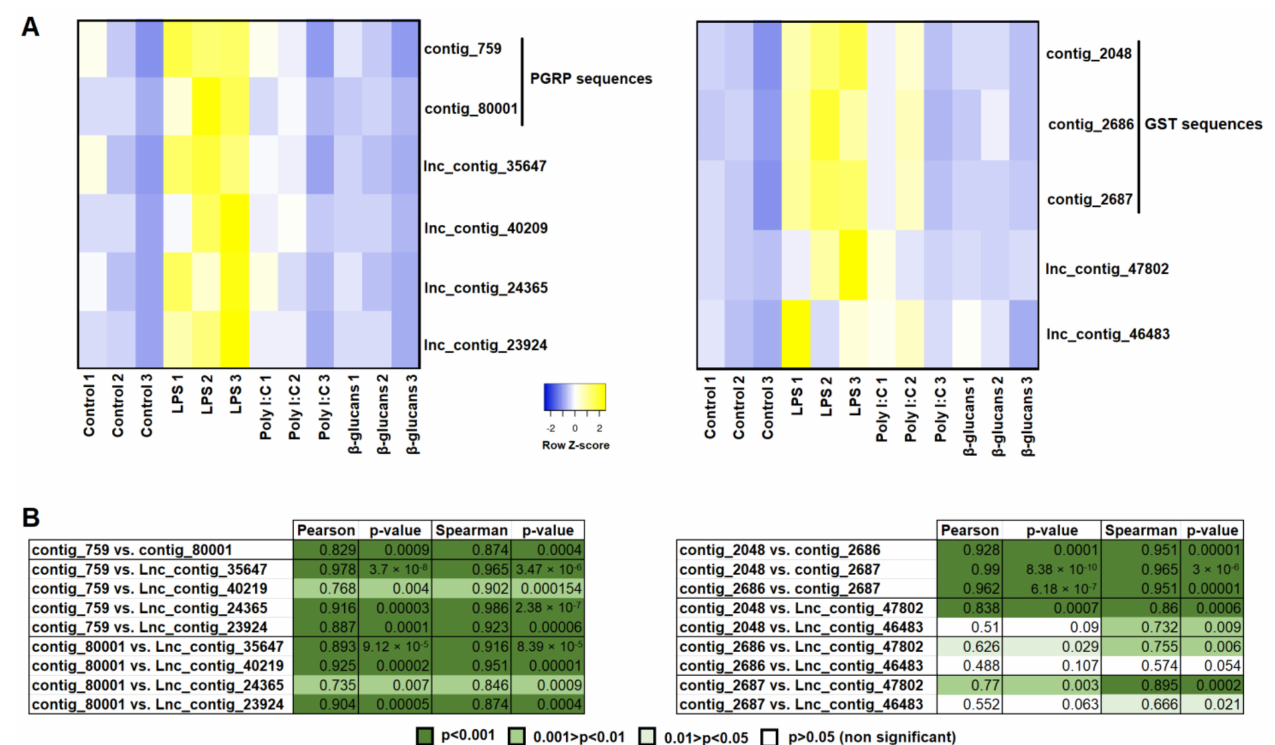
Figure 6. Correlation analyses of the DE lncRNAs and their neighboring coding genes. Those lncRNAs significantly modulated by LPS and located in the proximity of genes encoding for peptidoglycan recognition proteins (PGRPs) and glutathione S-transferases (GSTs), and the protein-coding contigs annotated as PGRPs and GSTs that were significantly induced by LPS, were selected. ( A ) Heat maps representing the TPM values of the lncRNAs and the protein-coding contigs per sample. Expression levels are represented as row-normalized values on a red–green color scale. ( B ) Correlation analysis between the lncRNAs and the protein-coding contigs. Pearson’s correlation coefficient and Spearman’s rank correlation coefficient were calculated, and their statistical significance ( p -value) was